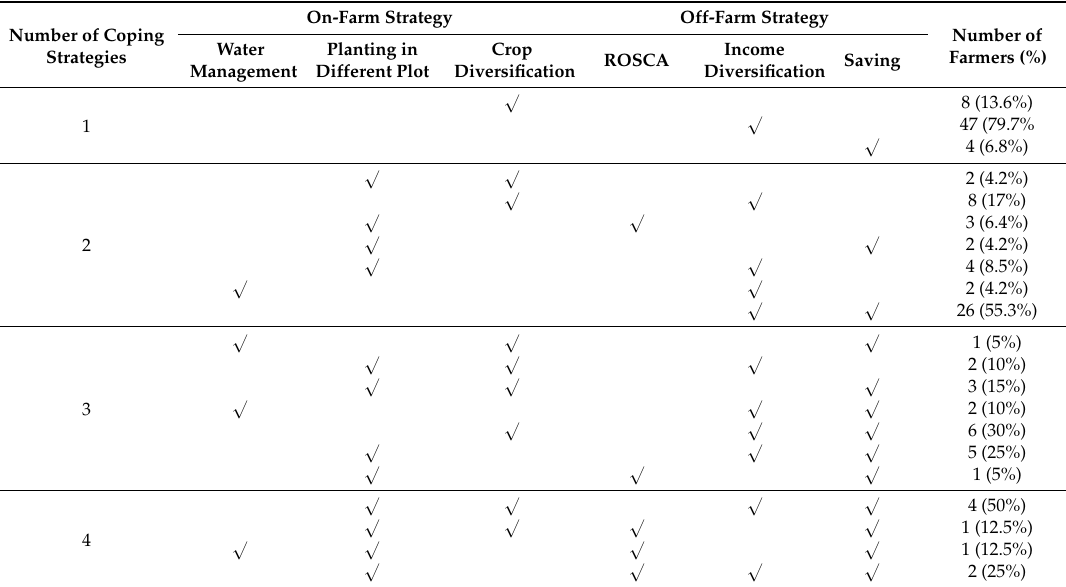
Table 6. Combination of ex ante coping strategies adopted by